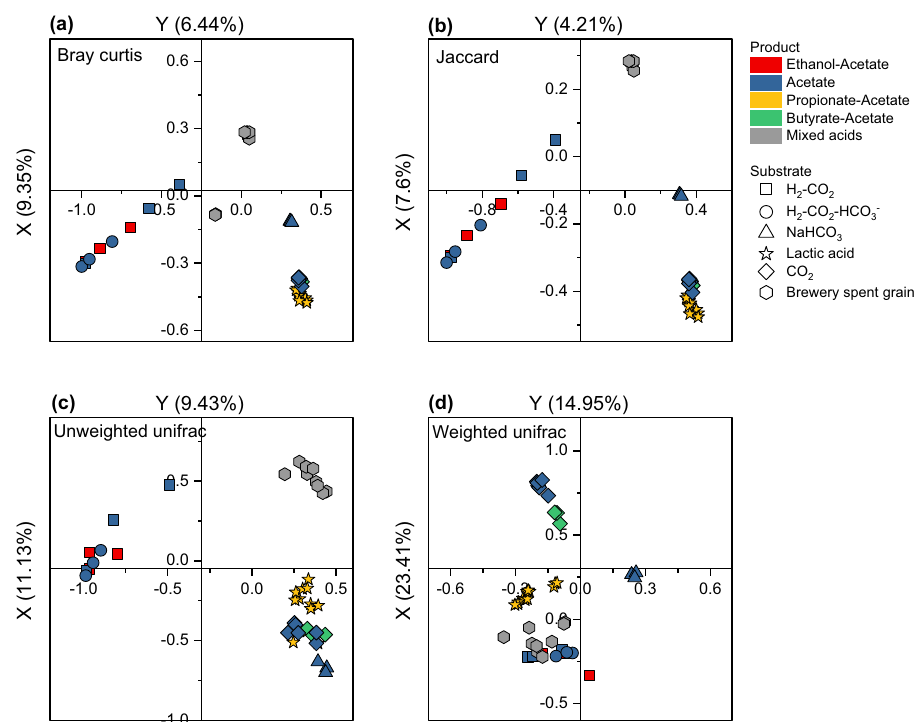
Fig. 7 PCoA of beta diversity. a Bray – Curtis distance, b Jaccard distance, c unweighted UniFrac distance, and d weighted UniFrac distance grouped by product (color) and substrate